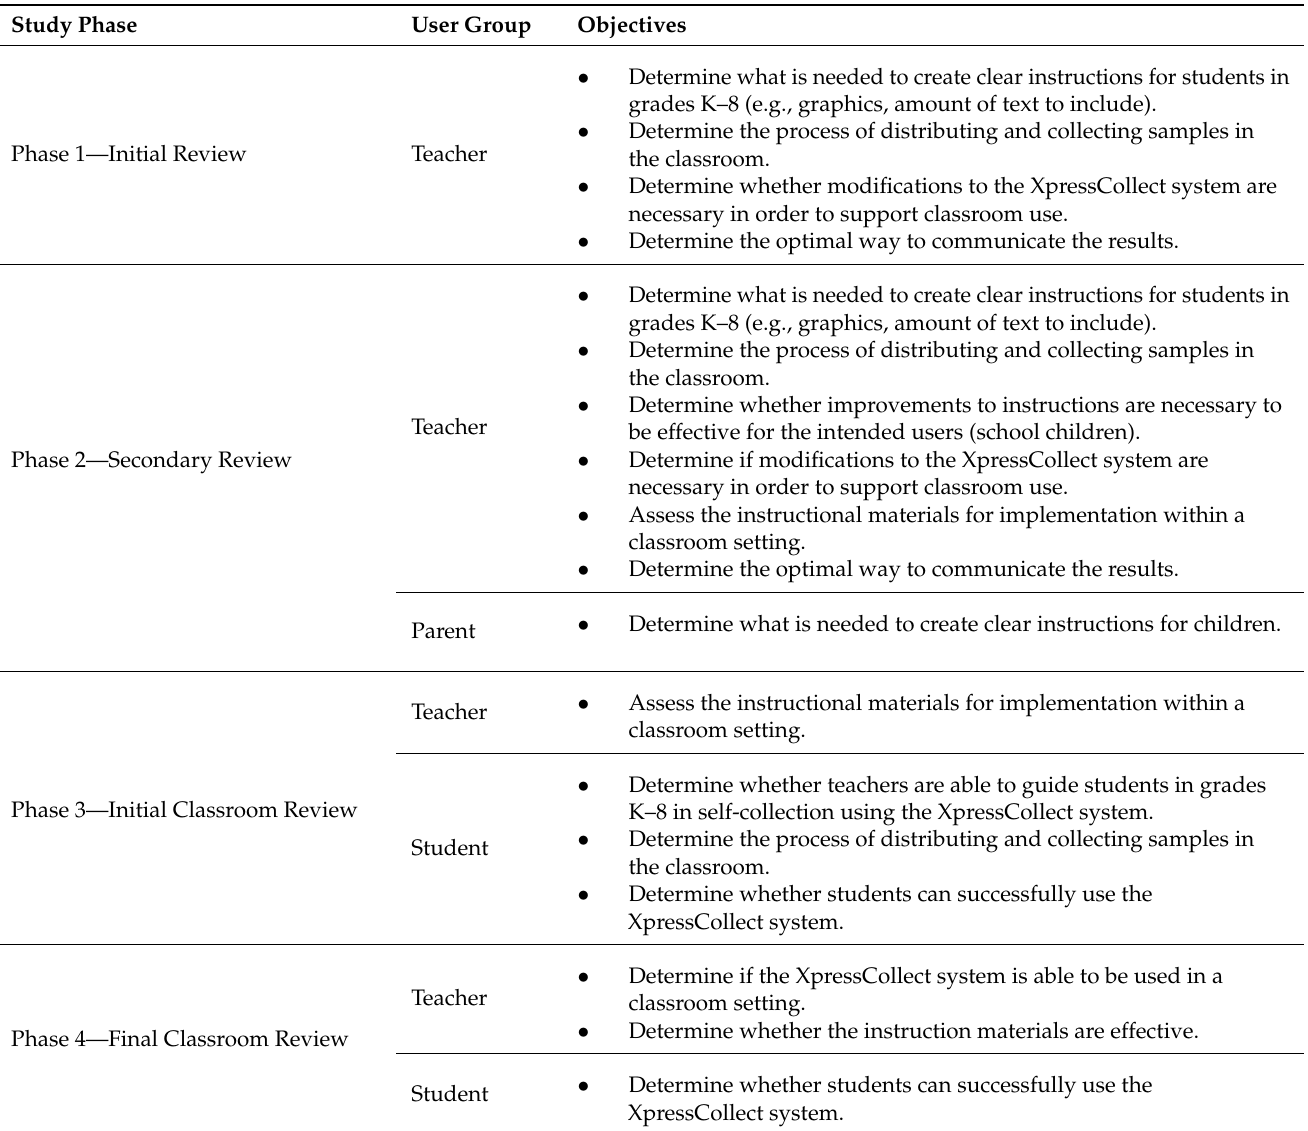
Table 1. Phased Study Objectives.